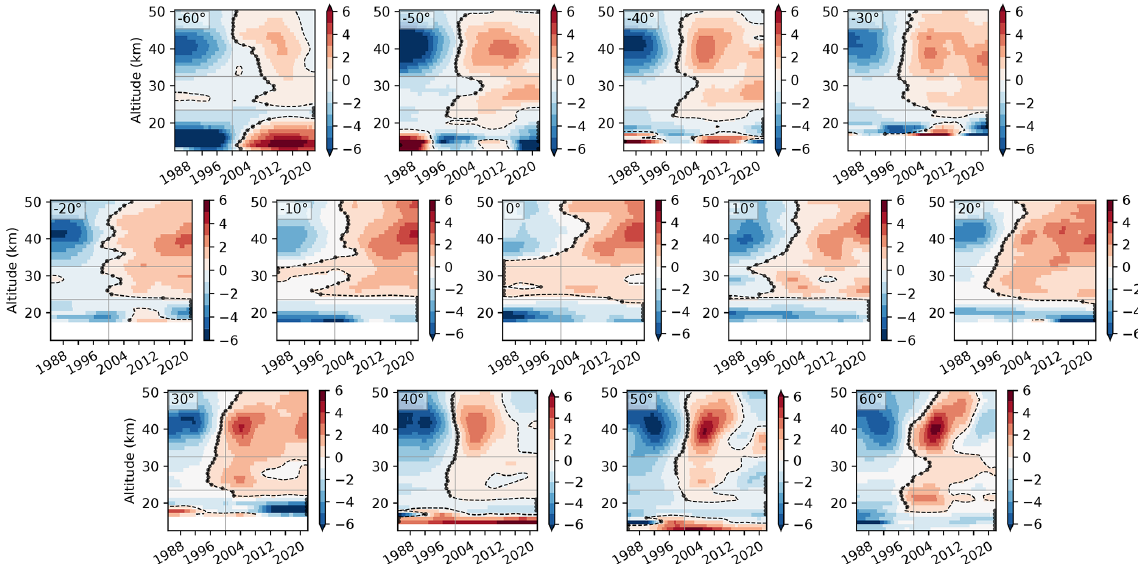
Figure 3. Slopes of the DLM trend results by latitude bin, scaled to units of percent per decade. The dashed lines show the zero slope contours, and the dots indicate the minima of the DLM trend fits. The vertical lines mark 1 January 2000, and the horizontal lines delineate the stratospheric